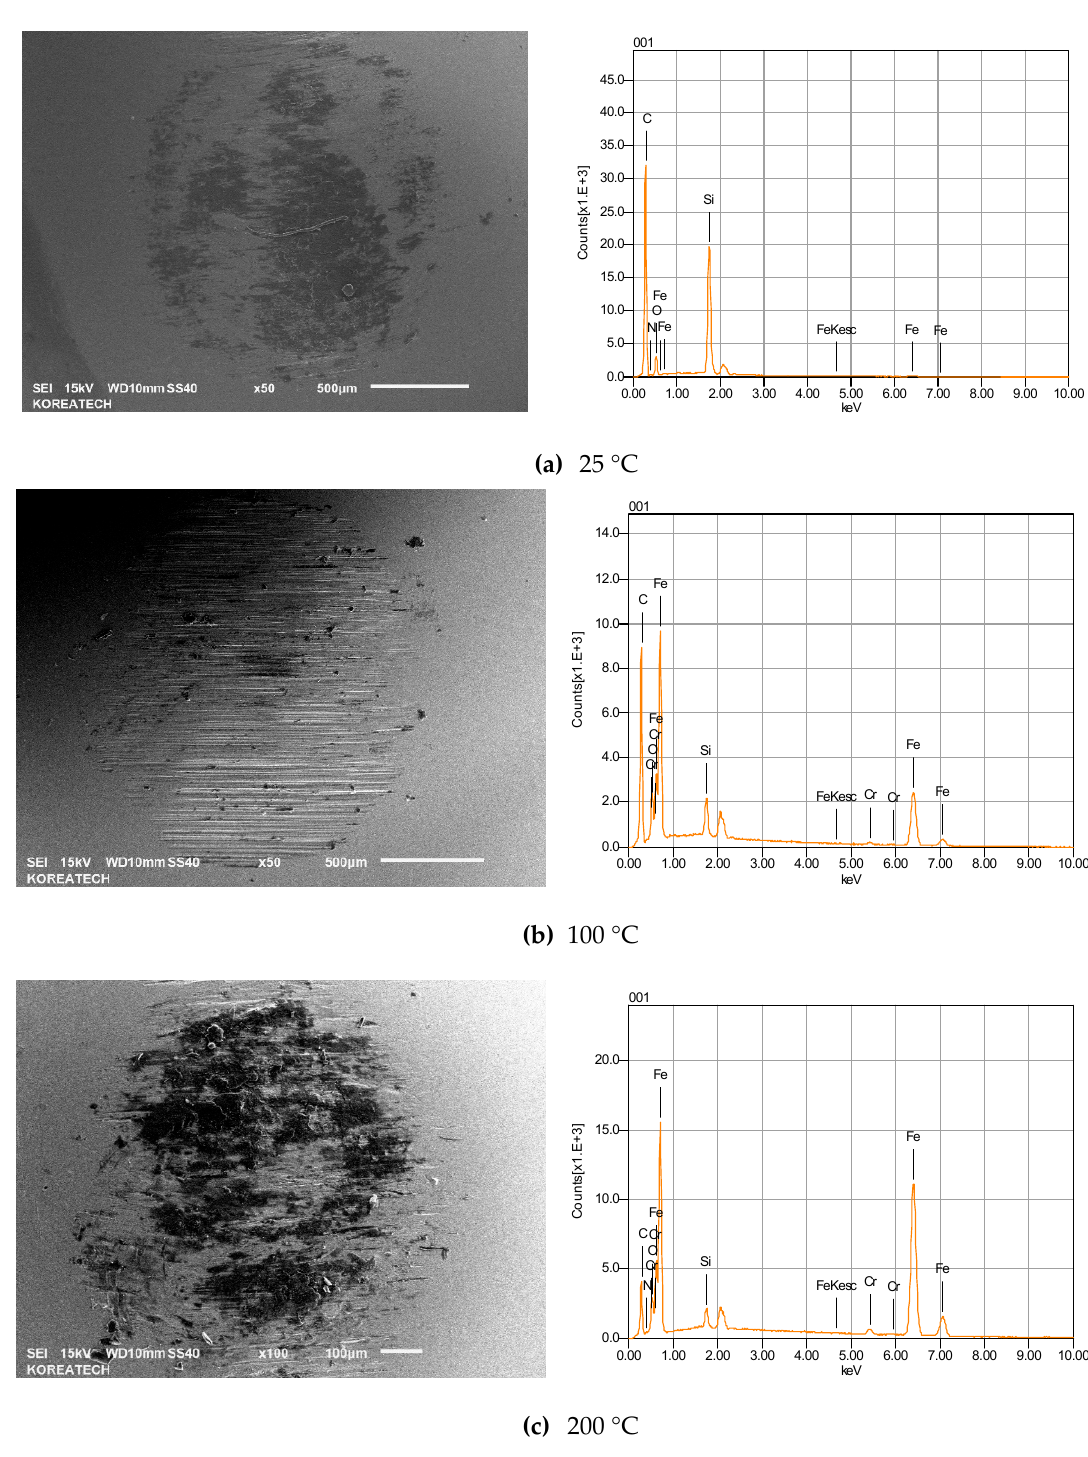
Figure 12. Wear volume of AISI52100 steel ball slid against the C/C-SiC composite at temperatures of 25, 100 and 200 °C. The friction and wear behavior of a C/C-SiC composite depends very much on the microstructure and surface properties. Graphitization of a C/C-SiC composite has an important influence on the friction and wear behavior of a C/C-SiC composite at the initial stage of braking. In this regard, the microstructure of the C/C-SiC composite after friction and wear test was characterized